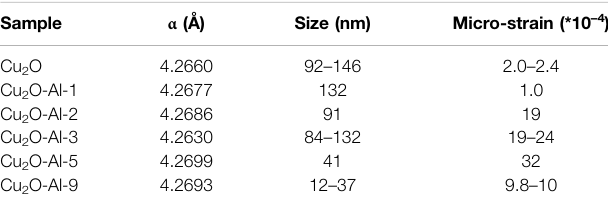
TABLE 3| Re fi nedparametersofmicrostructure: lattice constant α , crystallitesize and micro-strain.